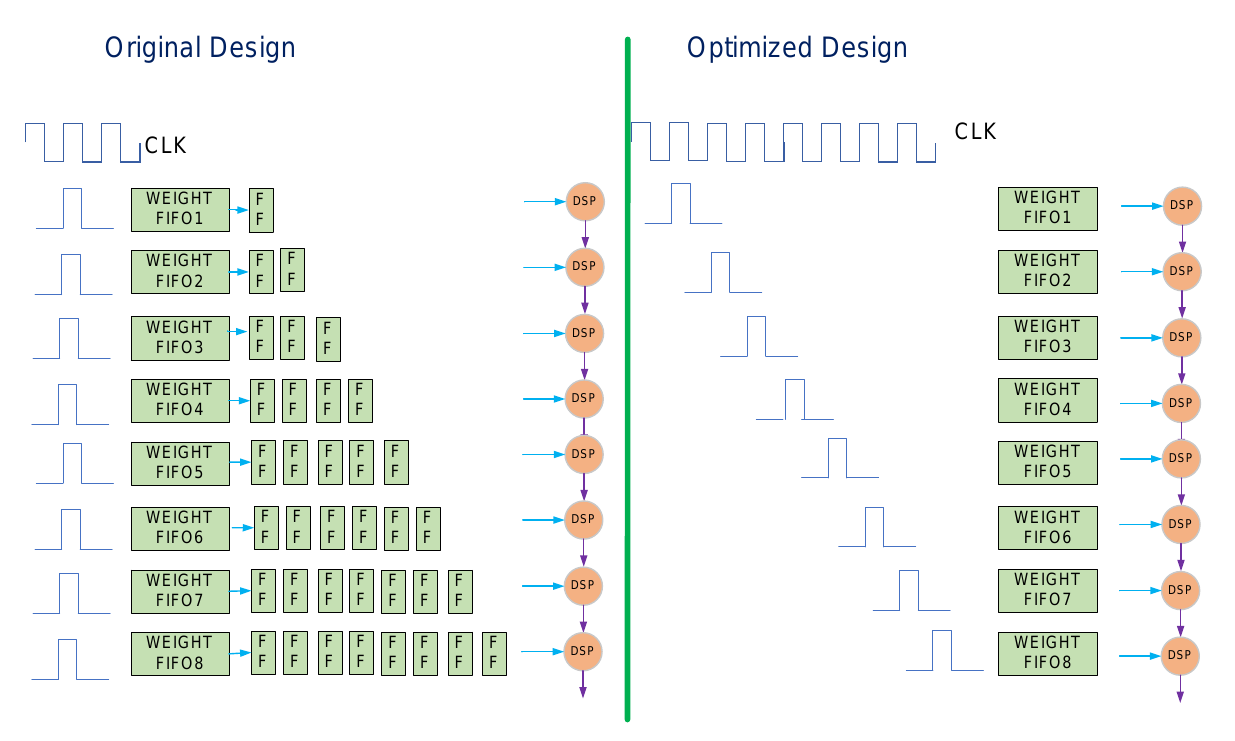
Figure 5. Optimized data read timing.